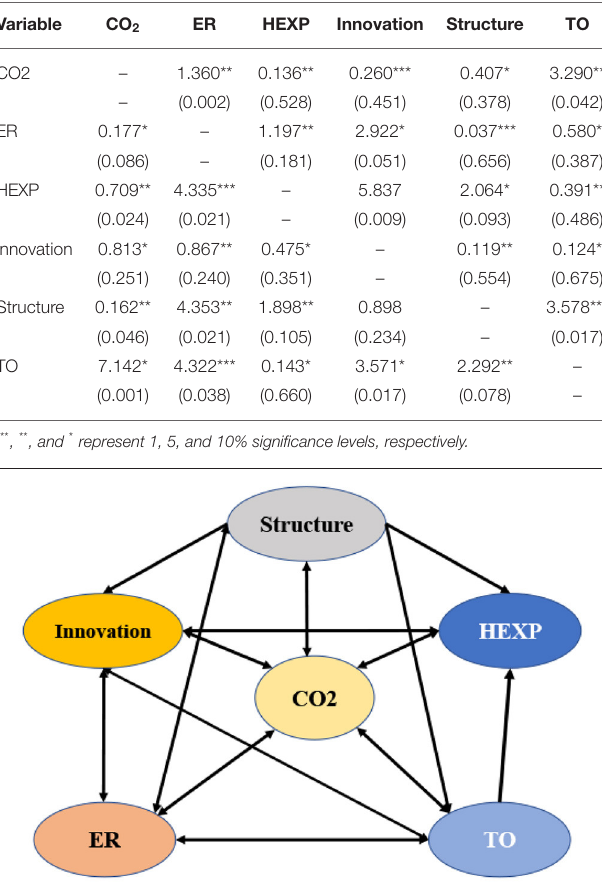
TABLE 6 | Regional heterogeneity estimation results.